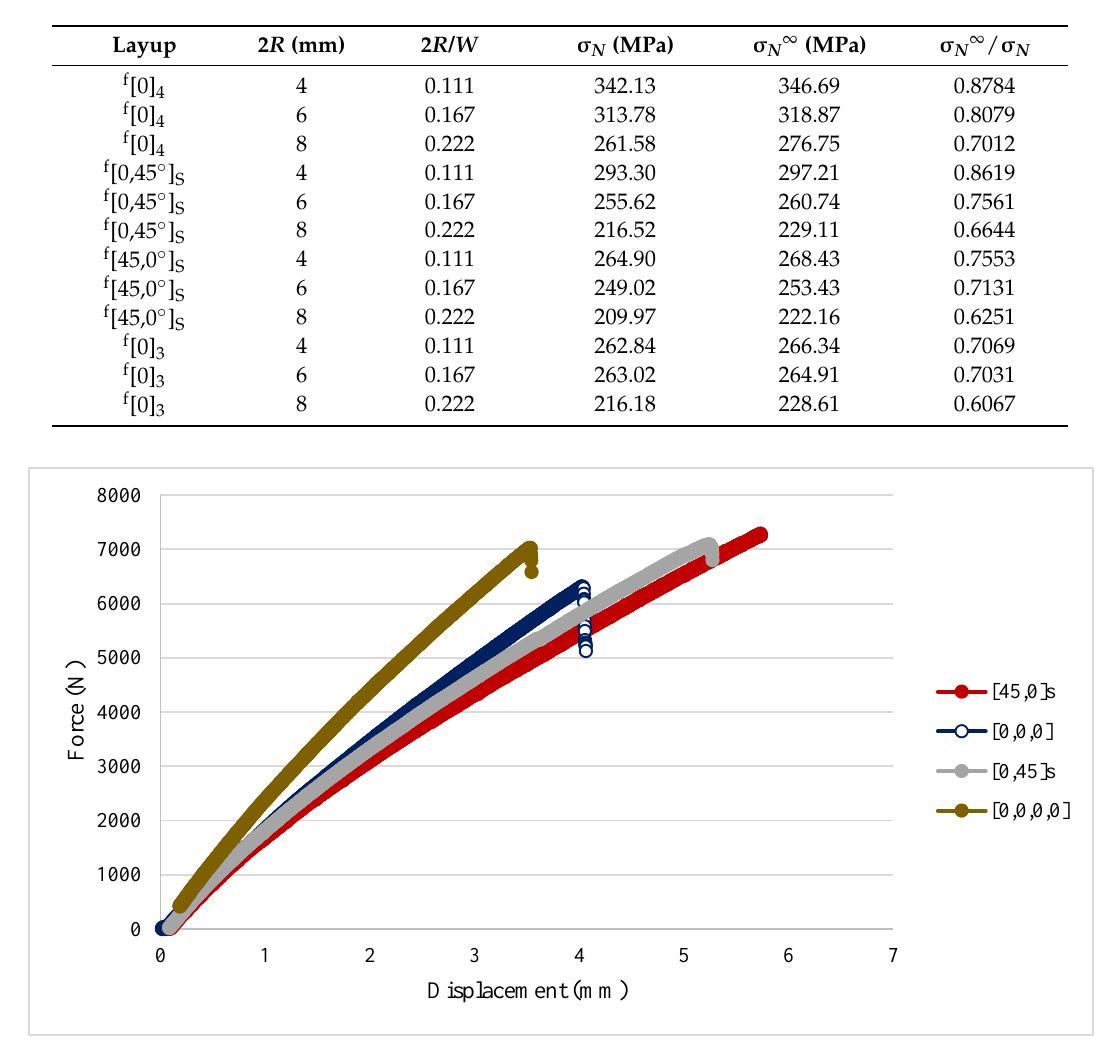
Table 2. Notched strength test results for various glass/epoxy layups.